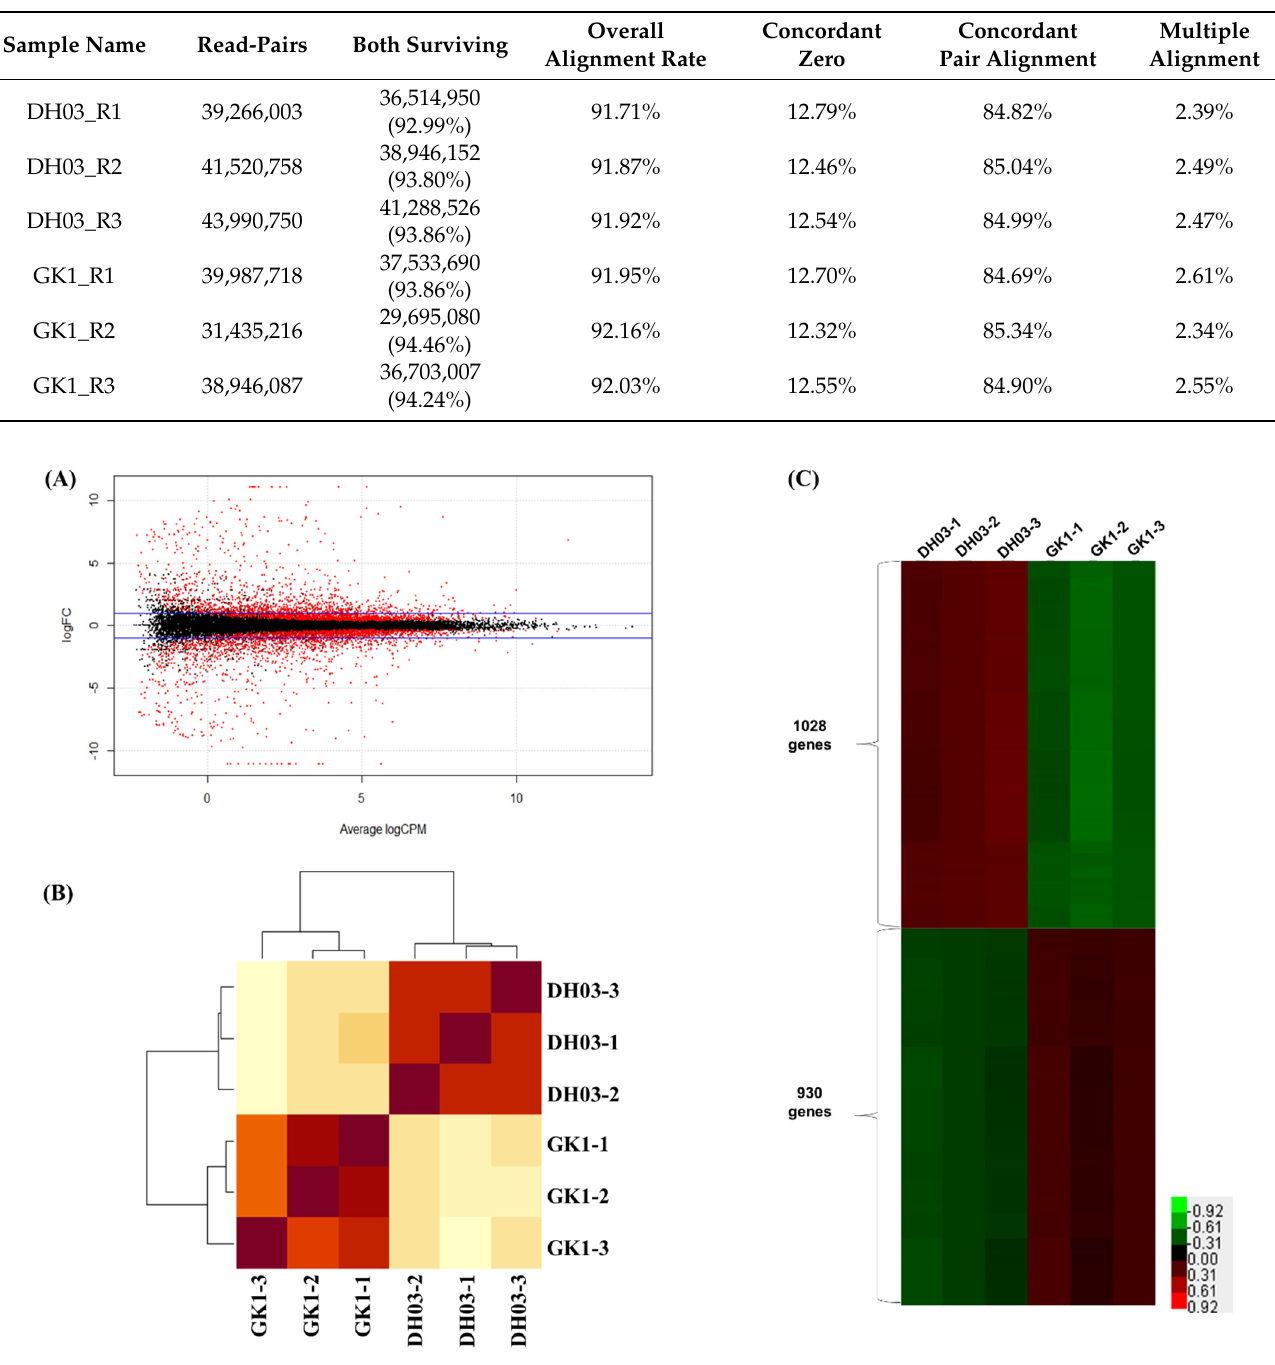
Table 1. Statistical analysis of Brassica rapa RNA sequencing (RNA-seq) reads. R1–3: three replications.